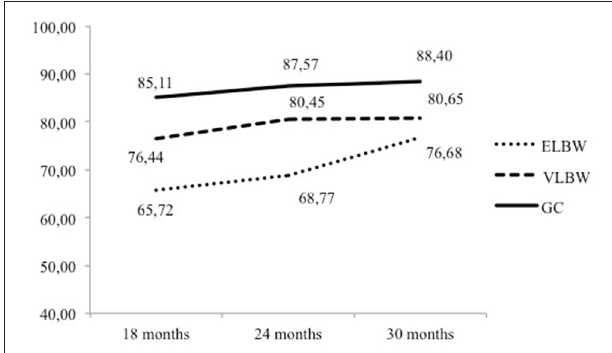
FIGURE 1 | Interaction between birth weight and child age on the EA clinical screener